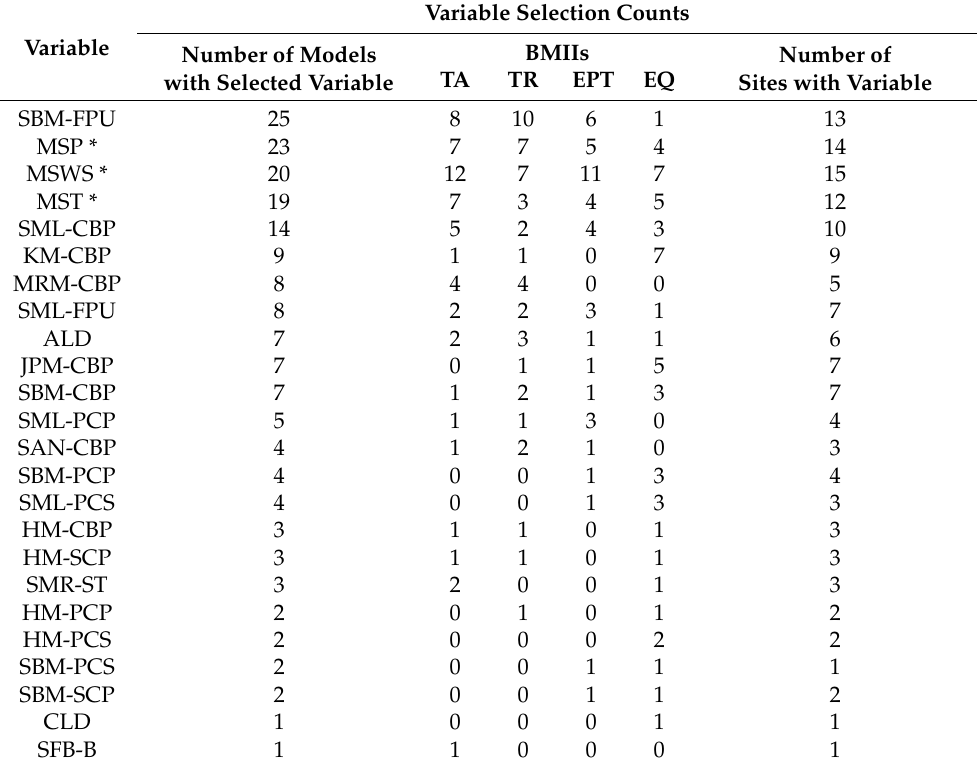
Table 1. Selection rates of industrial and climatic (*) variables, counts per BMII, and number of sites with a selected industrial and climatic variable returned by EN using an upper limit of zero (0) for industrial variables and unconstrained for MSP, MST, and MSWS; TA = total abun- dance; TR = taxon richness; EPT = percent EPT; EQ = equitability; 17 models fit as intercept only; SBM-FPU = fuel/plant use of petroleum coke at Suncor Basemine; MSP = mean summer precip- itation; MSWS = mean summer wind speed; SML-CBP = Syncrude Mildred Lake crude bitu- men production; KM-CBP = Kearl mine crude bitumen production; MRM-CBP = Muskeg River Mine crude bitumen production; SML-FPU = fuel/plant use of petroleum coke at Syncrude Mil- dred Lake; ALD = annual land disturbance; JPM-CBP = Jackpine Mine crude bitumen produc- tion; SBM-CBP = Suncor Basemine crude bitumen production; SML-PCP = Syncrude Mildred Lake petroleum coke production; SAN-CBP = Syncrude Aurora North crude bitumen production; SBM- PCP = Suncor Basemine petroleum coke production; SML-PCS = Syncrude Mildred Lake petroleum coke stockpile; HM-CBP = HorizonmMine crude bitumen production; HM-SCP = Horizon mine syn- thetic crude production; SMR-ST = Suncor MacKay River steam injection; HM-PCP = Horizon mine petroleum coke production; HM-PCS = Horizon mine petroleum coke stockpile; SBM-PCS = Suncor Basemine petroleum coke stockpile; SBM-SCP = Suncor Basemine synthetic crude production; CLD = cumulative land disturbance; SFB-B = Suncor Firebag bitumen